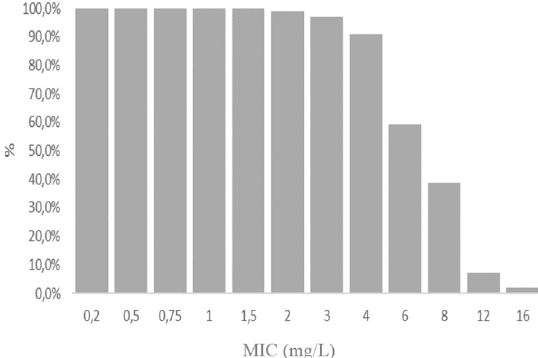
Fig. 1 Probability of PK/PD target attainment (Cmax/MIC to the